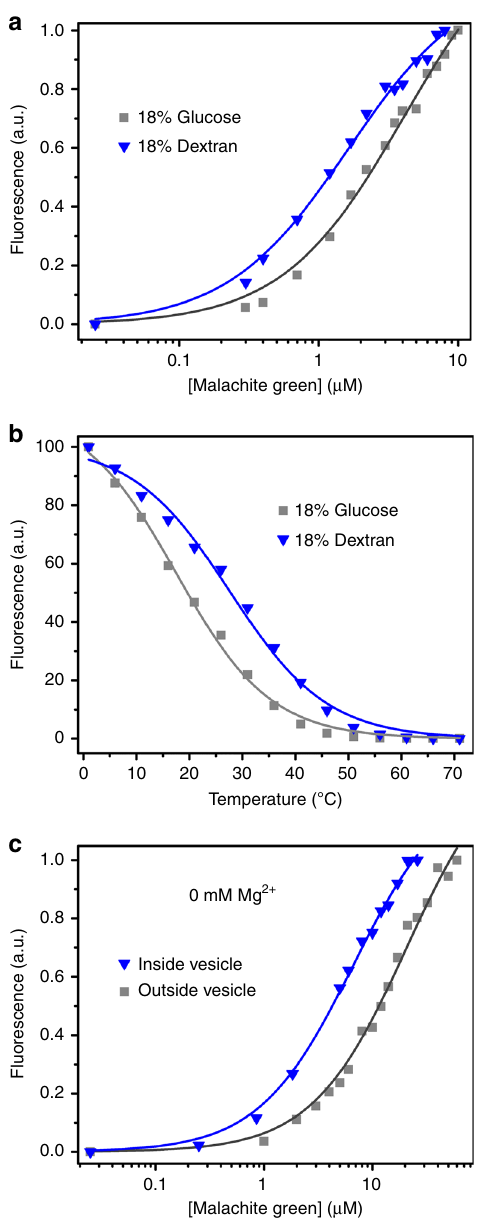
Fig. 6 MG aptamer af fi nity in the presence of different solutes. a The crowded conditions of 18% dextran (blue triangle, K D = 1.8 ± 0.4 μ M) lowers the K D compared to 18% glucose (gray square, K D = 3.6 ± 0.4 μ M). b The transition temperature ( T t ) of the MG aptamer (SHAPE construct) also increases in the presence 18% dextran ( T t = 28 ± 1.1 °C, blue triangles) compared to 18% glucose ( T t = 18 ± 0.8 °C, gray squares). c Binding curve of the MG aptamer in DOPG vesicles without Mg 2 + in the medium (gray square: outside vesicle, K D = 20 ± 1 μ M; blue triangle: inside vesicle, K D = 9.3 ± 2.4 μ M). Values given are mean ± standard